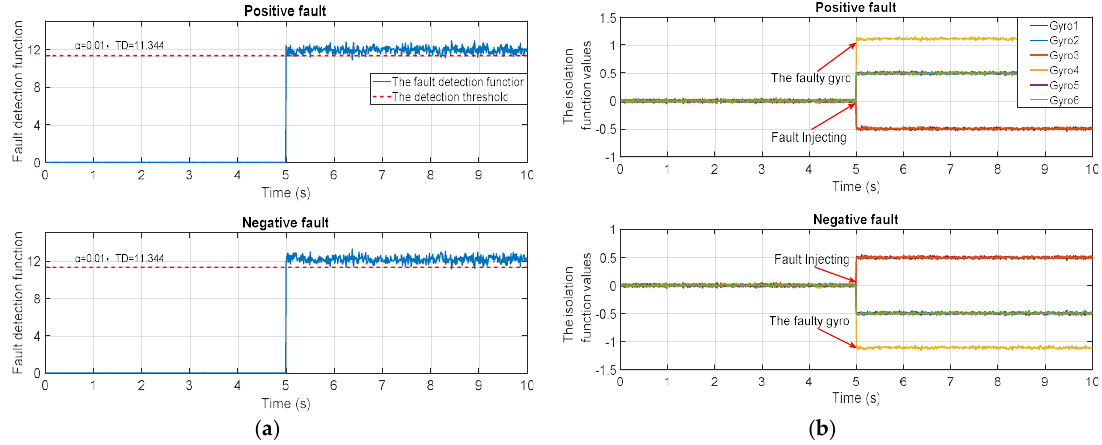
Figure 2. The fault detection and isolation function in two cases: ( a ) The detection functions of the positive fault and negative fault; ( b ) the isolation functions of the positive fault and negative fault.